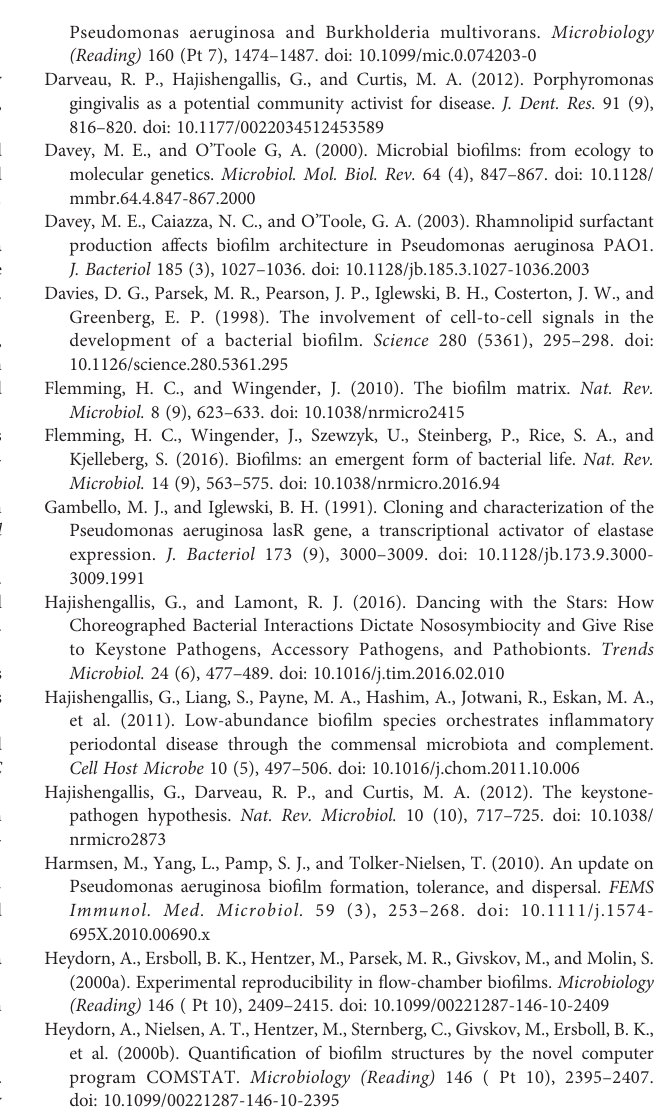
standard deviations (n=2). * denotes signi fi cant difference by Two-way ANOVA followed by Tukey ’ s post-test ( P <0.05). Supplementary Figure 3 | Growth curves of wild type and QS effector mutants of P. aeruginosa in M9 minimal medium containing glucose and casamino acids. P. aeruginosa wild type and different QS effector mutants were incubated at room temperature in 96well microtiter plates and absorbance (OD 600 ) recorded atregular intervals. Data shown are average of three independent biological replicates. Supplementary Figure 4 | Bio fi lm formation of wild type and QS effector mutants of P. aeruginosa in M9 minimal medium containing glucose and casamino acids. P. aeruginosa WTanddifferentQSeffectormutantswereincubatedatroomtemperaturein 24 well microtiter plates and the amount of bio fi lm formed quanti fi ed as absorbance (OD 570 ) after crystal violet staining. Data shown are average of 3 biological replicates. Supplementary Figure 5 | Fitness assays for wild type and QS effector mutants of P. aeruginosa in the presence of P. protegens in planktonic cultures. Equal volumes of P. aeruginosa wild type or QS effector mutants were mixed with P. protegens and allowed to grow for 24 h at room temperature. Bacteria were enumerated at zero and 24 h. Fitness was plotted as Log[Fold change of mutant/